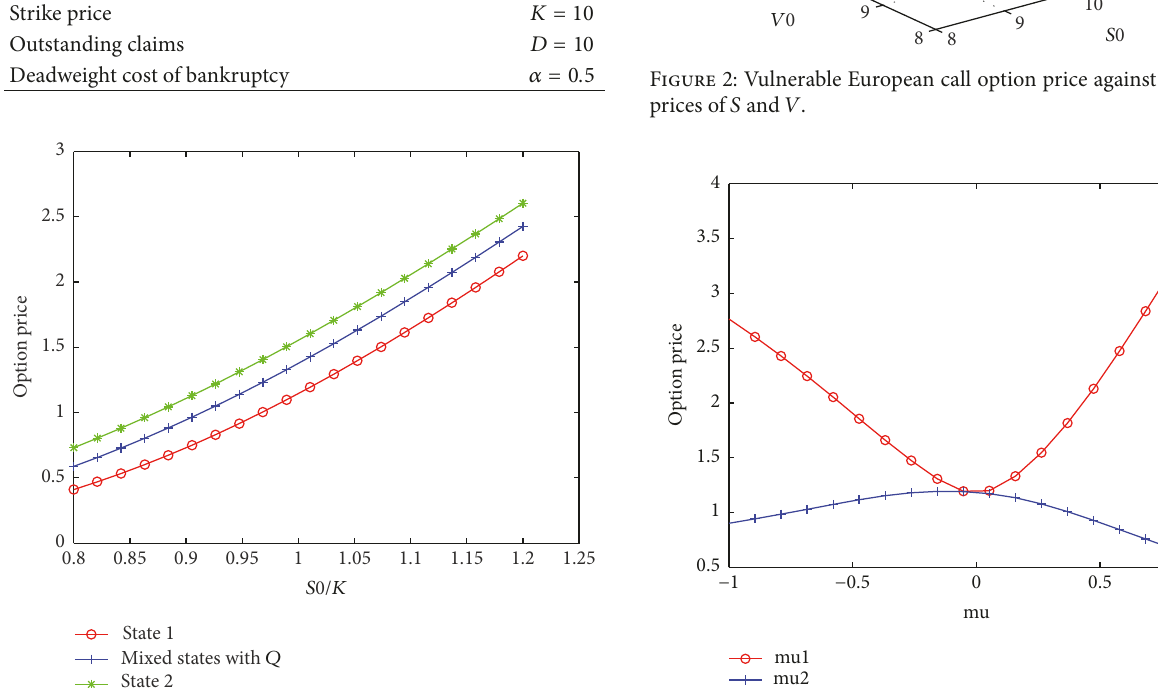
Figure 1: Vulnerable European call option price against spot-to- strike ratio.